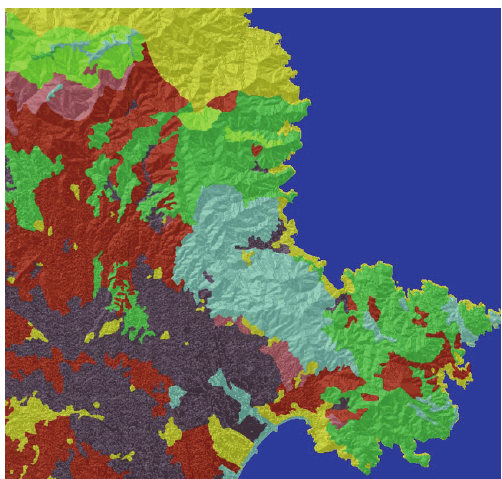
Figure4: CapdeCreus ,Catalonia(imagefromFARSITEsimulator). Different colors indicate different types of